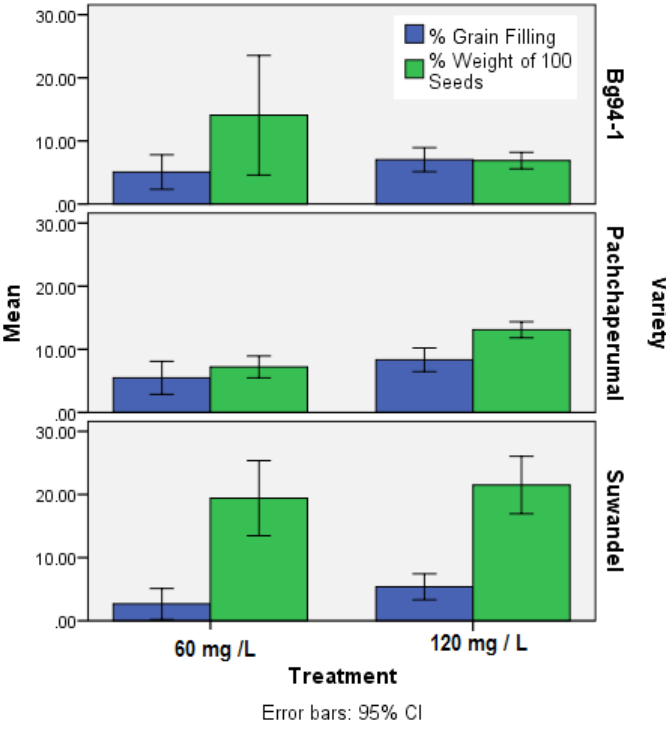
Figure 6: Variation of the standardized mean of percentage grain filling and percentage weight of 100 seeds of rice varieties across treatments of nano-ZnO 60 mg L -1 and 120 mg L -1